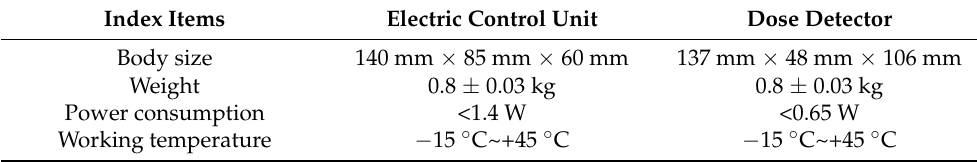
Table 2. The main engineering indexes of the radiation dose